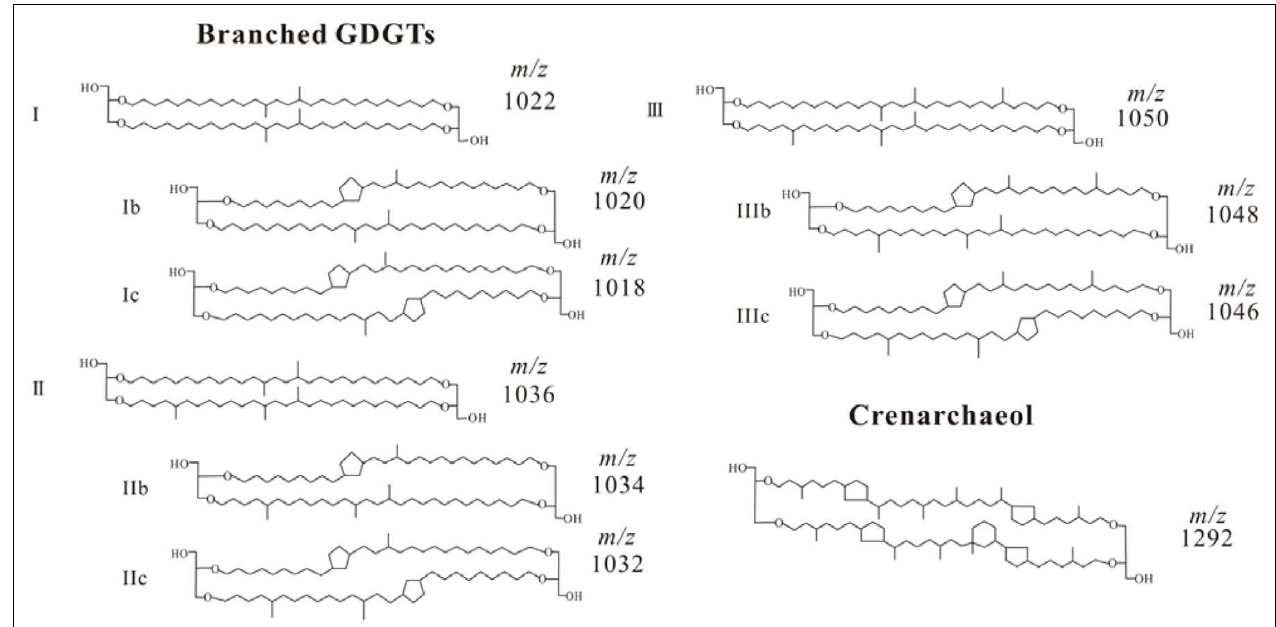
FIGUREA1 | Structures for branched GDGTs and